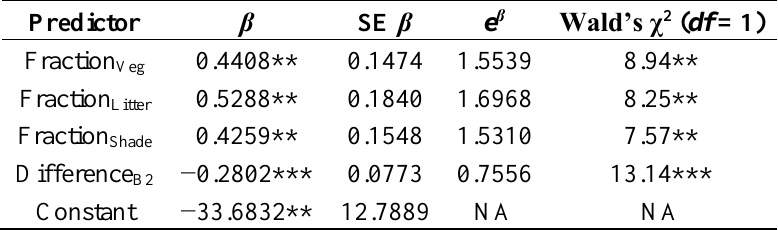
Table A2. Summary of predictor effects for Settlement_2 subgroup model.